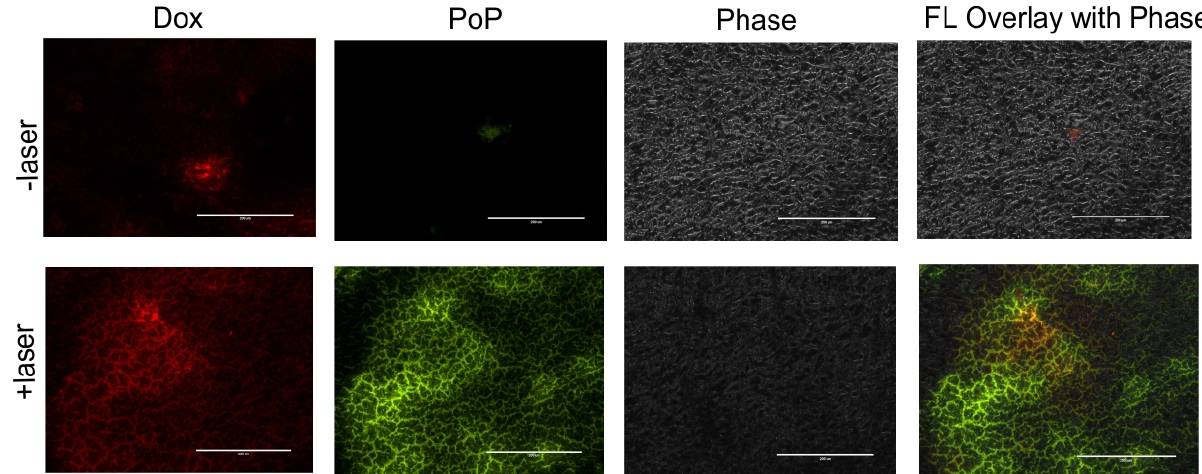
Figure 2. Micro-distribution of LC-Dox-PoP in tumor slices. Two groups of mice bearing MIA-PaCa2 tumor xenografts were intravenously administered LC-Dox-PoP (15 mg/kg Dox). 1 h after administration one group of mice was treated using a 665 nm laser at 150 mW/cm 2 at total laser fluence of 50 J/cm 2 . Mice were sacrificed 24 h after drug administration. Representative tumor slice fluorescent micrographs are shown for n = 3 mice per group. Red signal shows Dox distribution and green signal shows PoP distribution. Scale bar, 200 µm.